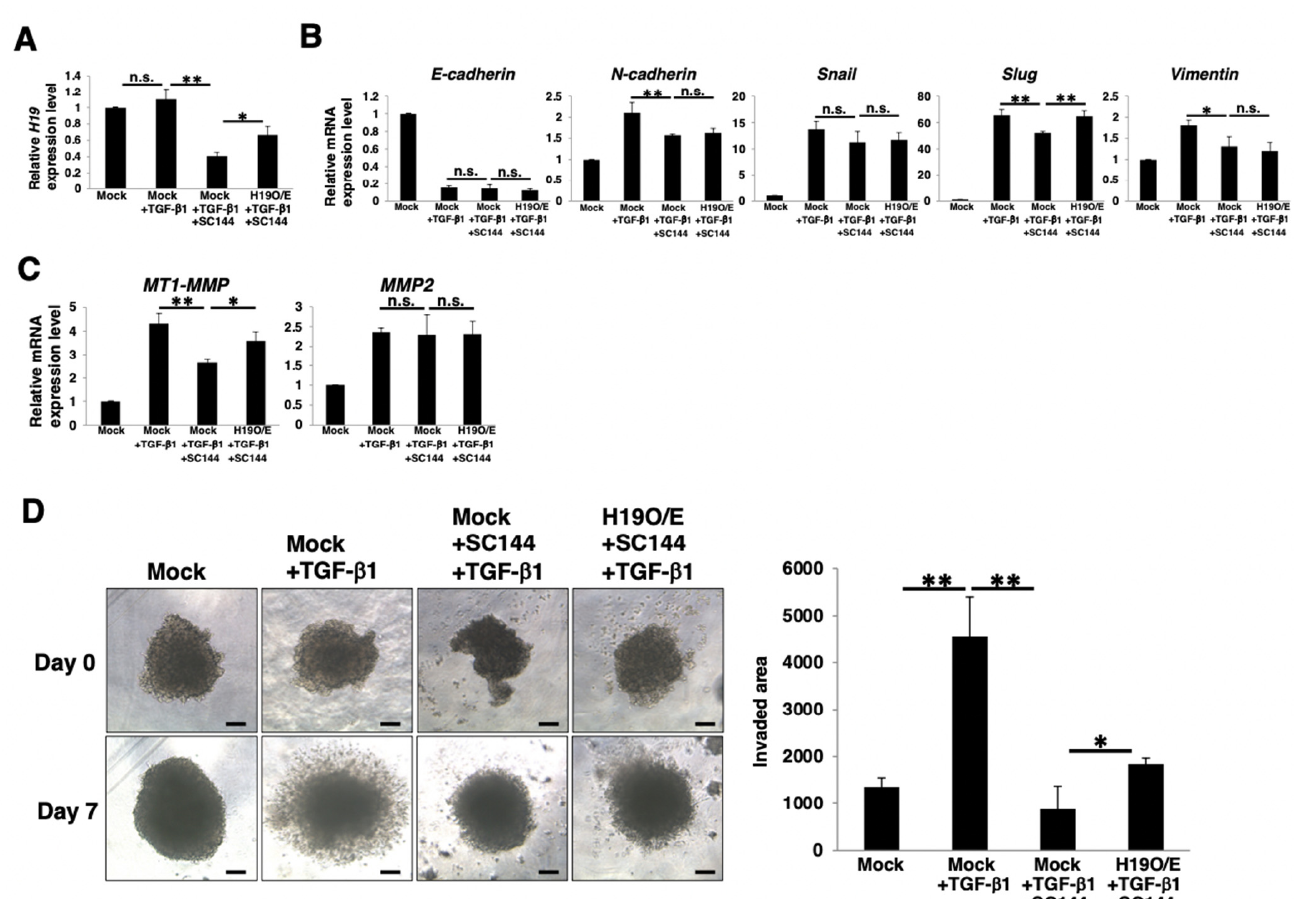
Figure 7. Contribution of H19 to EMT and invasion in PDAC sphere cells. PANC-1 cells stably transfected with mock or H19 expression vector were cultured for 4 days in 3D (sphere) conditions with or without 1 µ M SC144 and then further incubated for 3 days with or without 10 ng/mL of TGF- β 1. The cells were harvested and then used in the following experiments. ( A ) Real-time qPCR analysis of H19 . Results are normalized to values obtained for mock-transfected sphere cells (value = 1). Results are presented as means ± SD from three independent experiments. ( B ) Real-time qPCR analysis of EMT markers. Results are normalized to values obtained for mock-transfected sphere cells (value = 1). Results are presented as means ± SD from three independent experiments. ( C ) Real-time qPCR analysis of MT1-MMP and MMP2 . Results are normalized to values obtained for mock-transfected sphere cells (value = 1). Results are presented as means ± SD from three independent experiments. ( D ) 3D-invasion assay. Scale bar: 5 µ m. The histograms indicate the invaded area. Results are presented as means ± SD from four sphere images. * p < 0.05; ** p < 0.01, n.s.: not significant, O/E: